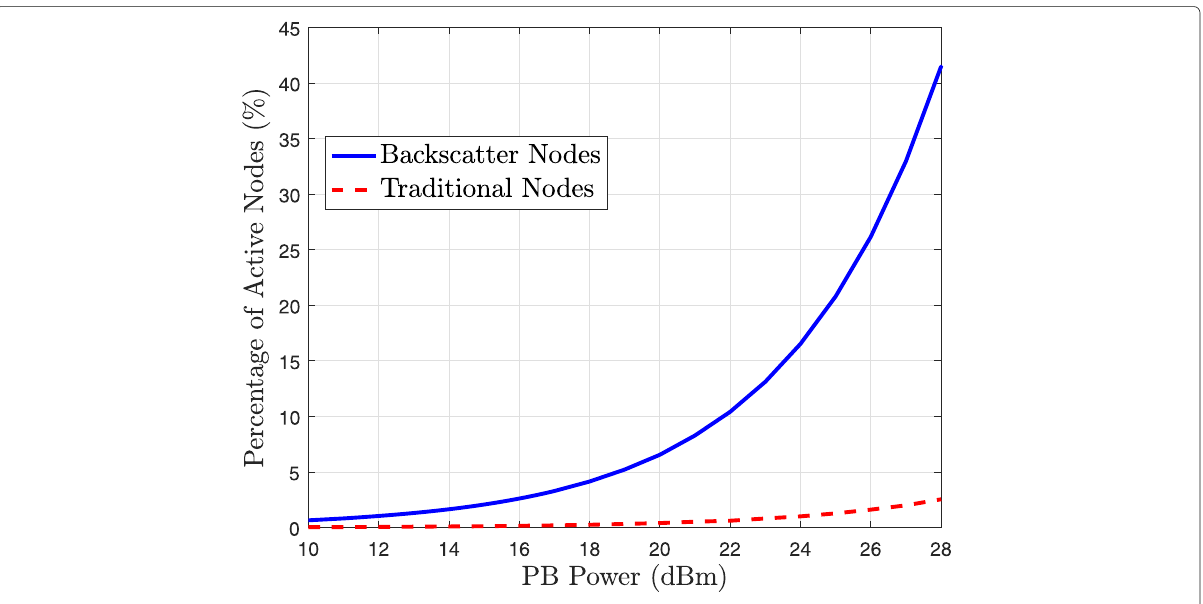
Fig. 11 Percentage of active nodes versus PB power